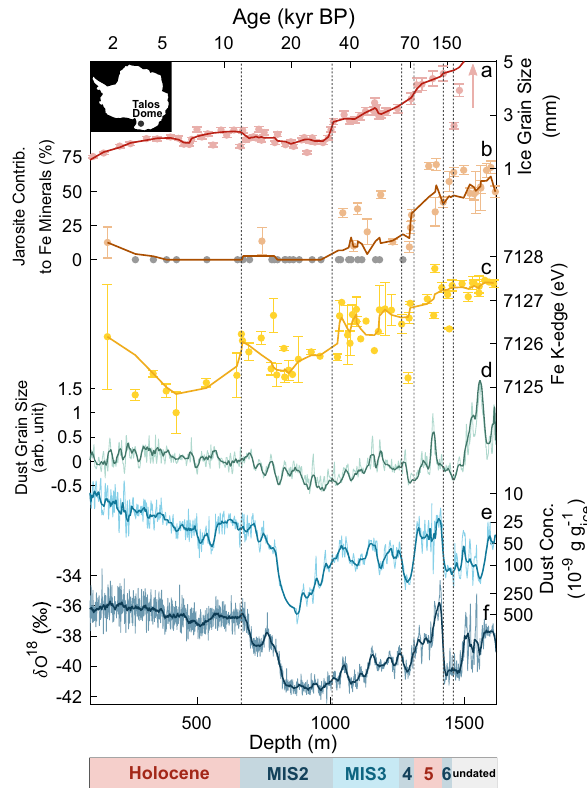
Fig. 1 Records from the Talos Dome ice core. a Ice-grain size; data from Montagnat et al. 24 . The arrow indicates the very large ice crystals (larger than 40 cm, observed but not quanti fi ed) below the depth of 1481 m. b Jarosite relative contribution with respect to Fe minerals found in TALDICE dust; grey dots refer to samples where jarosite was not identi fi ed, error bars correspond to standard deviations. c Energy position of the K- edge X-ray absorption line of the iron fraction within TALDICE dust, error bars correspond to standard deviations. d Dust grain size index; developed to highlight the granulometric anomalies observed in dust from the deepest part of TALDICE. e Concentration of insoluble mineral dust in ice samples along TALDICE: part of the data from Albani et al. 66 . f TALDICE δ 18 O record; data from Stenni et al. 21 . The AICC2012 chronology 22,23 has been used to prepare the fi gure. The lower bar refers to the Marine Isotopic Stages (MIS) covered by